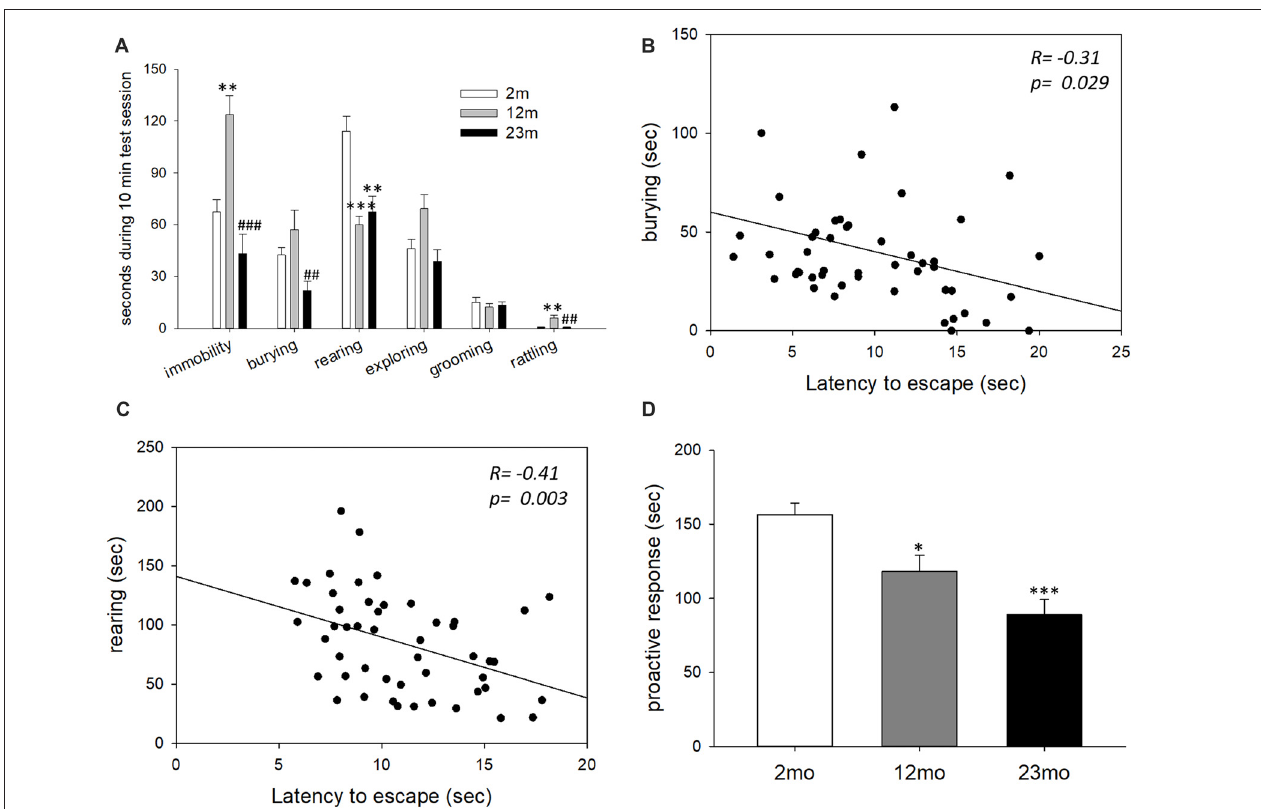
FIGURE 2 | Age-related differences in coping style in the shock prod test. (A) Behavioral responses in the shock prod test. There were significant differences in immobility ( F ( 2,46 ) = 11.5, p < 0.001), burying ( F ( 2,46 ) = 5.7, p = 0.006), rearing ( F ( 2,46 ) = 12.3, p < 0.001) and rattling ( F ( 2,46 ) = 6.6, p = 0.003) by age group but not in exploring ( F ( 2,46 ) = 0.16, p = 0.86) and grooming ( F ( 2,46 ) = 0.08, p = 0.92). Immobility was higher in the 12-month-old mice than the 2-month-old mice ( p = 0.003) and lower in the 23-month-old mice than the 12-month-old mice ( p < 0.001). Burying response decreased in the 23-month-old mice compared to the 12-month-old mice ( p = 0.005). Rearing response was reduced in the 12-month-old ( p < 0.001) and 23-month-old ( p = 0.001) mice compared to the 2-month-old mice. Rattling response increased in the 12-month-old mice compared to the 2-month-old mice ( p = 0.006) but decreased in the 23-month-old mice compared to the 12-month-old mice ( p = 0.009). (B) Correlation between the burying response in the shock prod test and escape latency in the active avoidance test. (C) Correlation between the rearing response in the shock prod test and escape latency in the active avoidance test. (D) Time of proactive responses (burying + rearing) in the shock prod test. There were significant differences between age groups ( F ( 2,46 ) = 13.5, p < 0.001). Pairwise comparisons showed a significant decrease in proactive responses in the 12-month-old ( p = 0.017) and 23-month-old ( p < 0.001) mice compared to the 2-month-old mice. All data are the mean ± SEM. 2 mo: